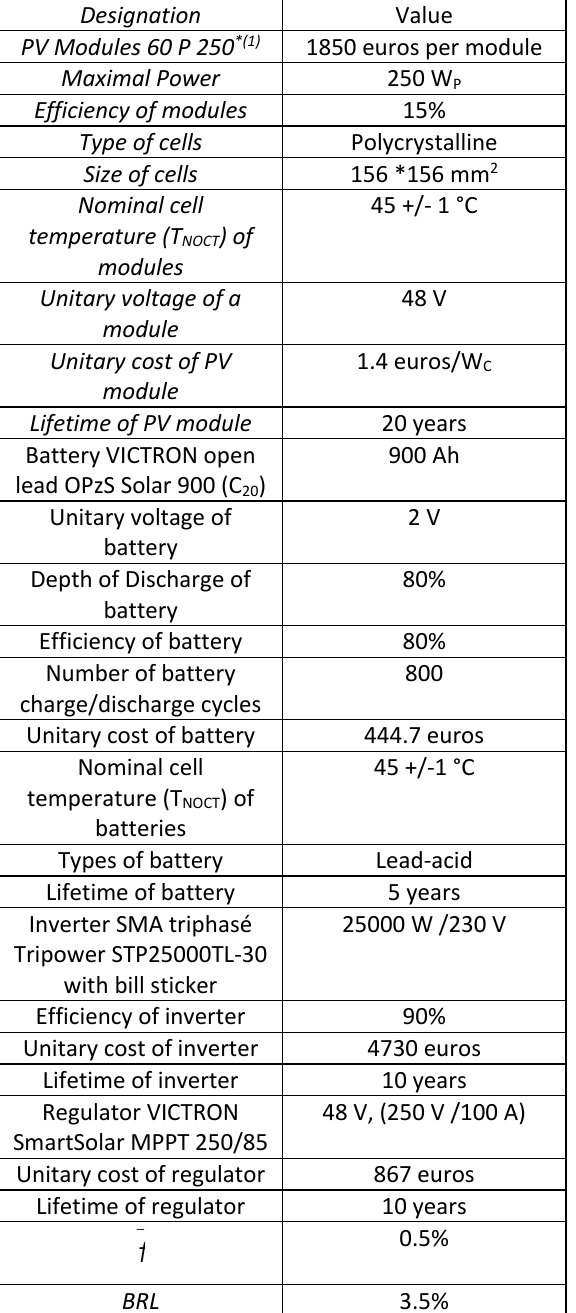
Table 1: Technical and economical specifications of the different components of the